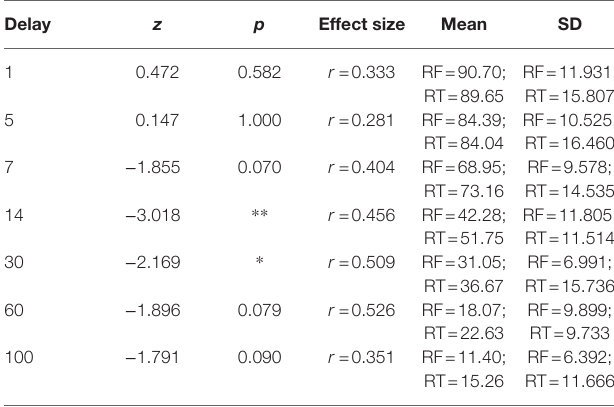
TABLE 2 | The statistical results for each delay between the RF and RT